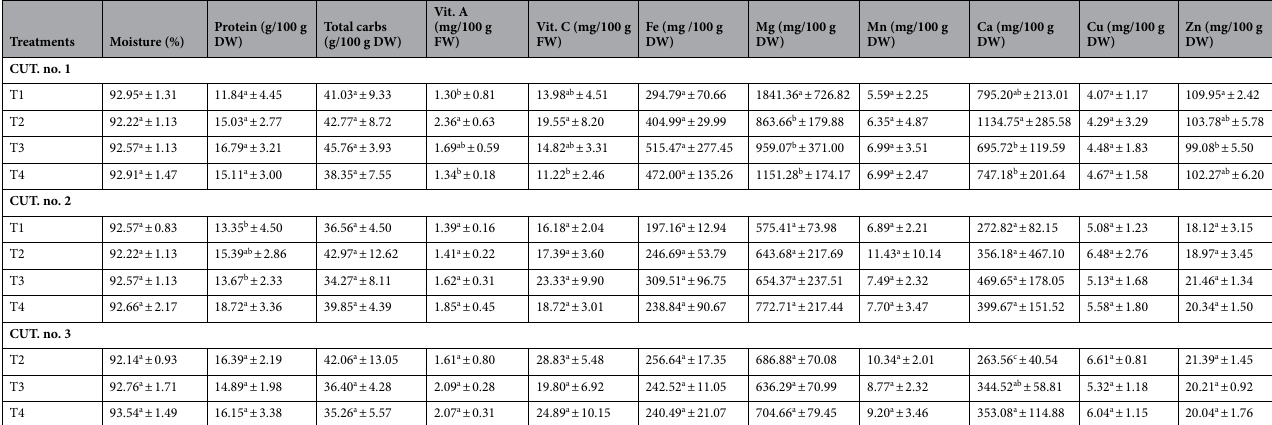
However, no significant difference was noted in Mn and Cu contents in all cut numbers.